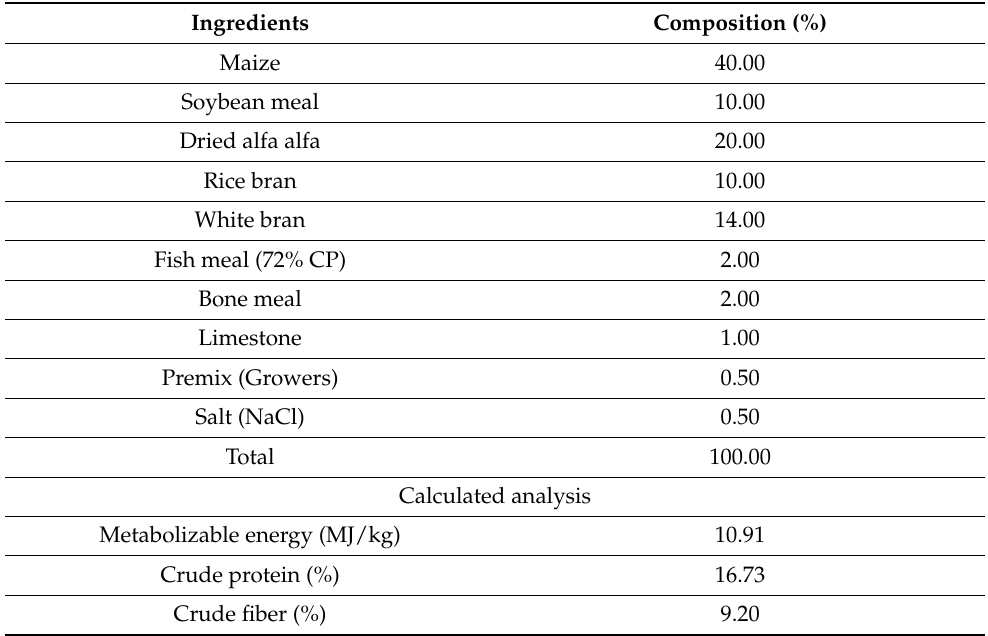
Table 1. Gross composition (%) of concentrate diet for the growing